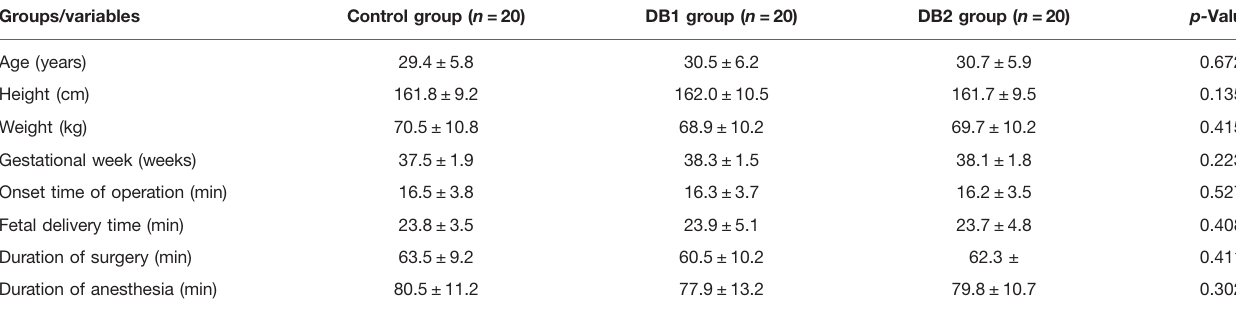
TABLE 1 | Comparison of demographic and surgical indicators among three groups (mean±SD). Groups/variables